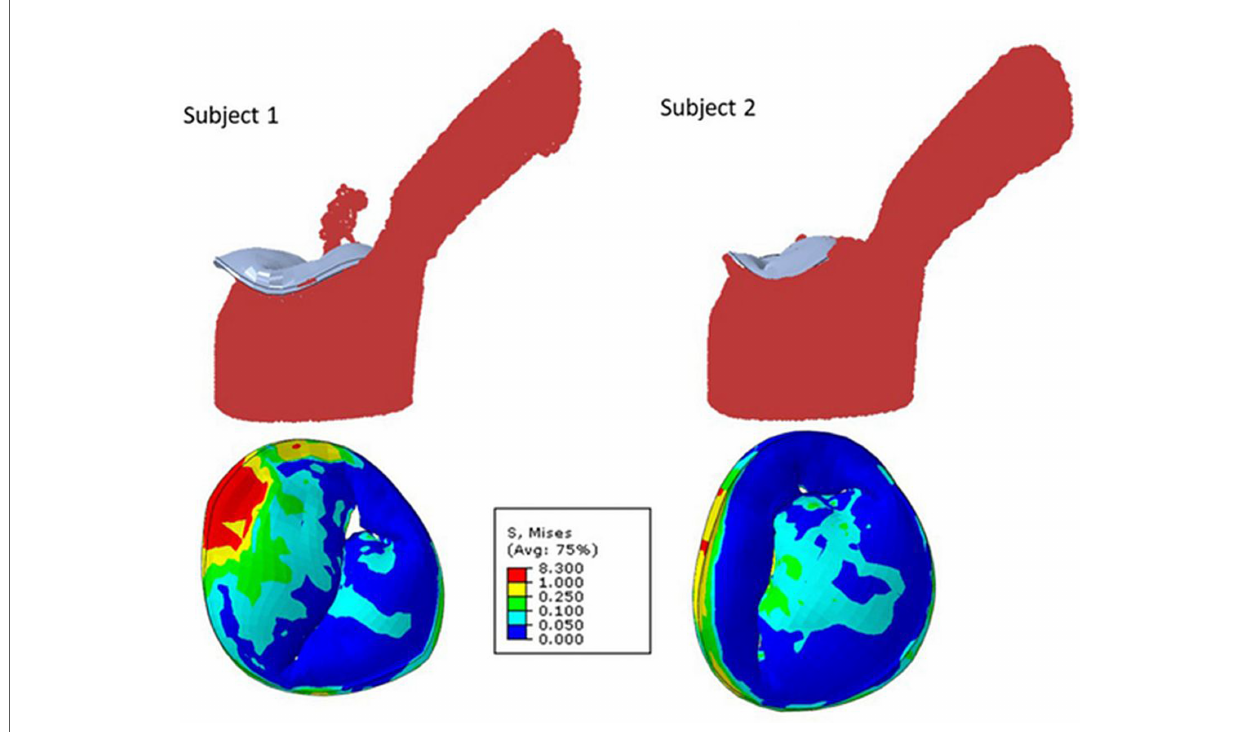
FIGURE 2 Mitral regurgitation models for two different subjects showing smooth particle hydrodynamics of regurgitation (upper row), and mitral valve lea fl et von Mises stresses at systole